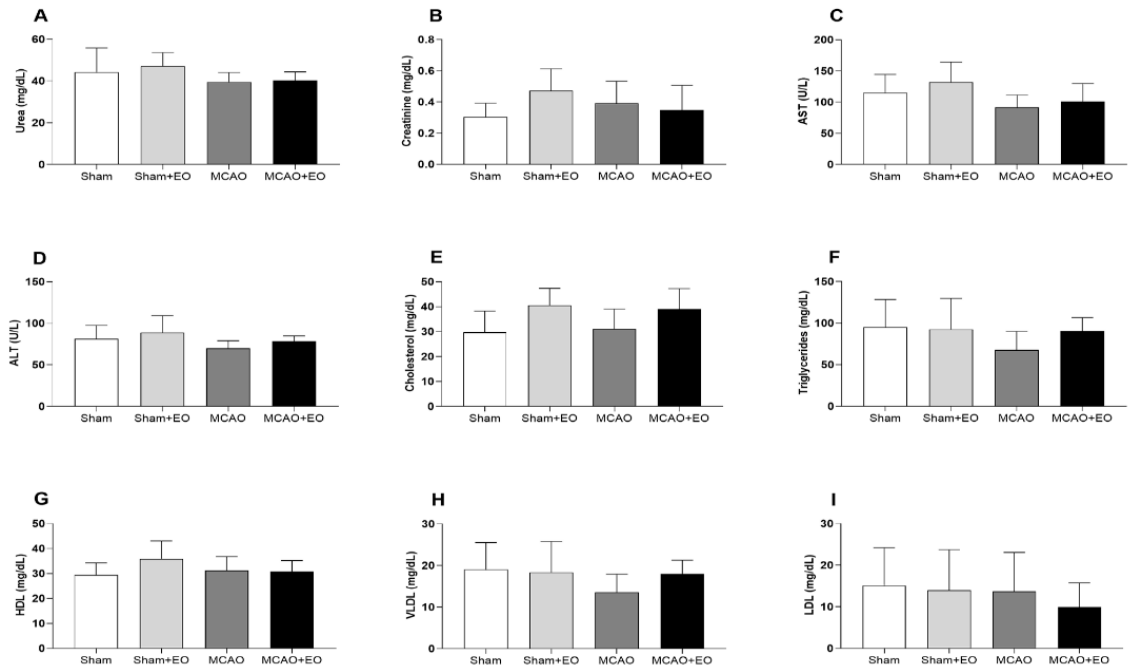
Figure 5. Biochemical analysis of the animals submitted to middle cerebral artery occlusion (MCAO) with clarified Euterpe oleracea extract. ( A ) Urea (mg/dL). ( B ) Creatinine (mg/dL). ( C ) AST (aspartate aminotransferase, U/L). ( D ) ALT (alanine aminotransferase, U/L). ( E ) Cholesterol (mg/dL). ( F ) Triglycerides (mg/dL). ( G ) HDL (high-density lipoprotein, mg/dL). ( H ) VLDL (very low-density lipoprotein, mg/dL). ( I ) LDL (low-density lipoprotein, mg/dL). The data are presented as the mean ± SD ( n = 6–9 animals/group).